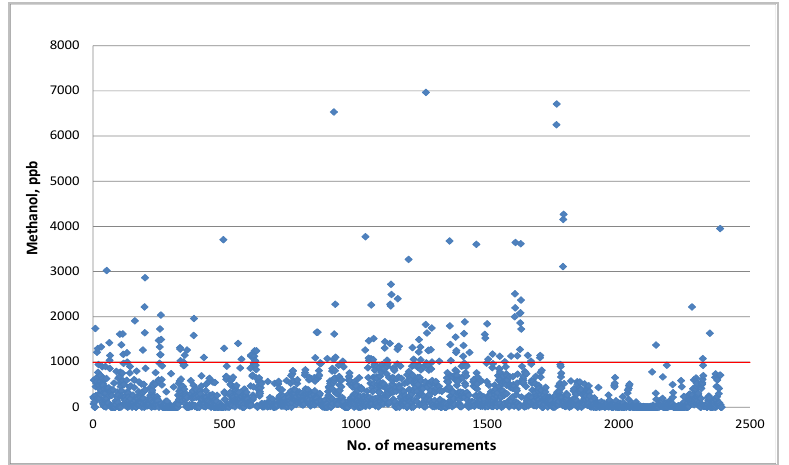
Figure 4. Statistical overview of methanol concentration from the EEINT database.